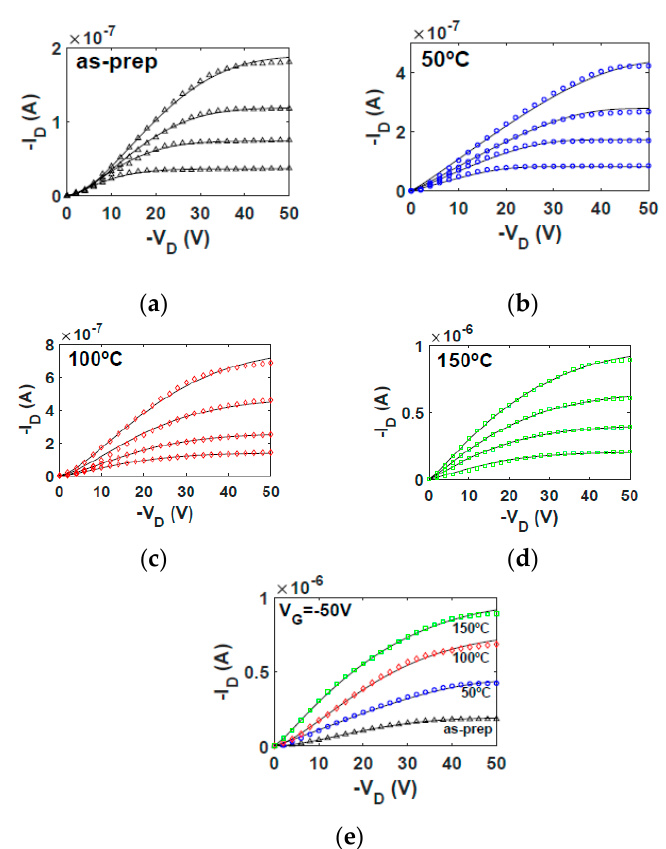
Figure 4. Output characteristics of NiPc 6 organic thin-film transistors (OTFTs) at di ff erent annealing temperatures. ( a – d ) Comparison of experimental I D − V D curves (symbols) and our calculations using Equations (5) and (18) (solid lines) at di ff erent annealing temperatures: ( a ) as-prepared; ( b ) 50 ◦ C; ( c ) 100 ◦ C; and ( d ) 150 ◦ C. V G is swept from − 20 (bottom) to − 50 V (top) with a − 10 V step. ( e ) Output characteristics at V G = − 50 V of transistors annealed at di ff erent